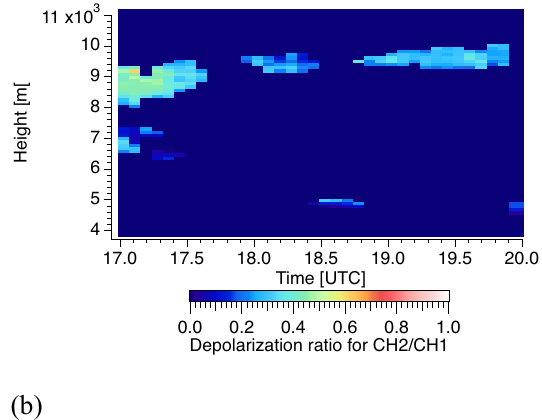
Fig.2 Same as Fig.1 but for off-beam channel. (a) attenuated backscattering coefficient for CH.3 and (b) depolarization ratio for tilt angle of 10 mrad by CH.3 and